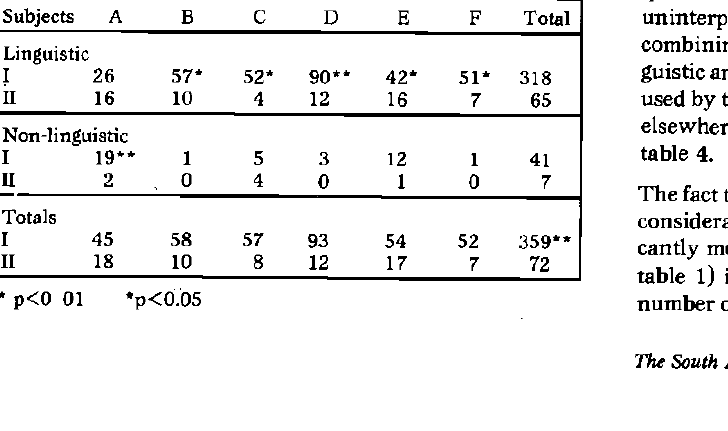
Table 3: Linguistic/non-linguistic Responses for all sub- jects in Interactions I and Π Subjects